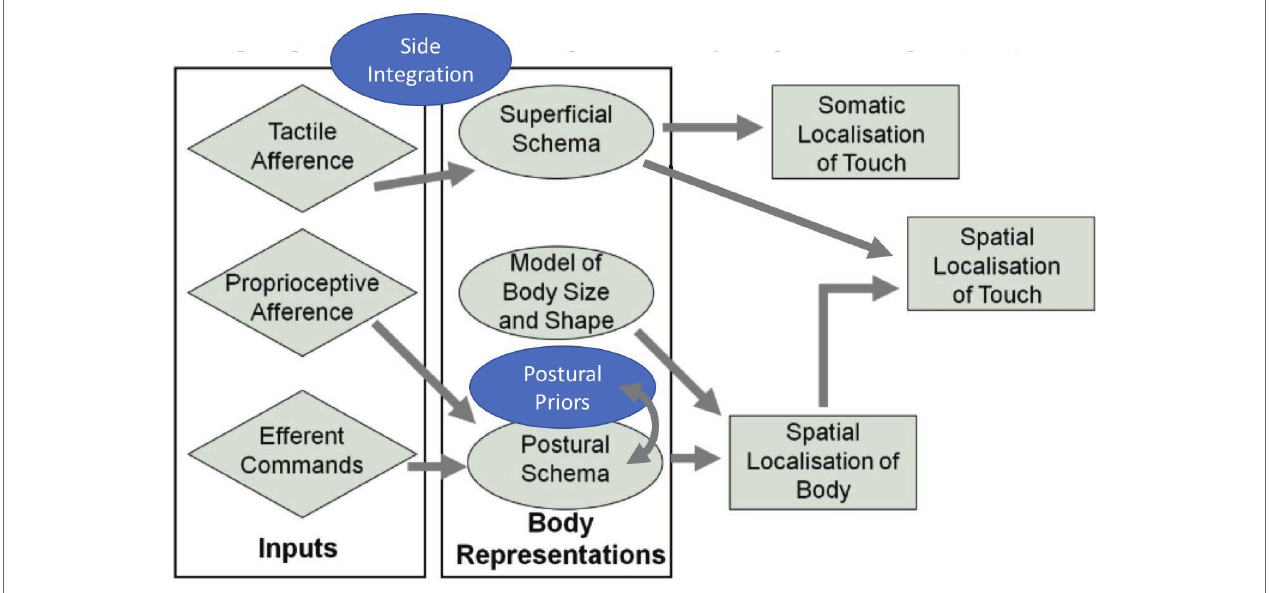
FIGURE 4 | Revised model of somatosensory processing. Addition of the concepts “side integration” and “postural priors” (in blue) to the model initially proposed by Longo et al., 2010. Adapted from Longo et al. (2010). © 2010 by Elsevier. Permission for the use of the image has been obtained from the